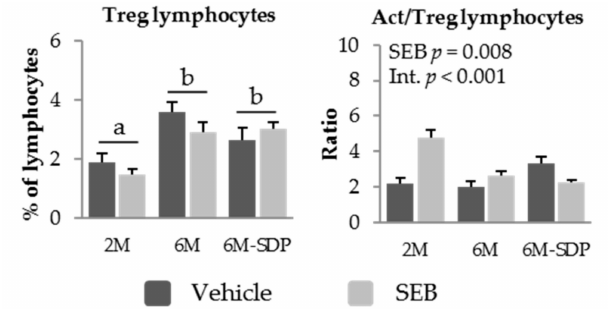
Figure 6. Cell recruitment ( A ); percentage of activated (Act.) Th lymphocytes ( B ); percentage of regulatory (Treg) Th lymphocytes ( C ); and the ratio of activated to regulatory Th lymphocytes ( D ), in Peyer’s patches (PP) of SAMP8 mice of the 2-month-old (2M), 6-month-old (6M), and 6-month-old fed spray-dried plasma (6M-SDP). The dark grey bars represent groups that received the vehicle and the light grey bars represent mice administered with S. aureus enterotoxin B (SEB). Results are expressed as means ± SEM ( n = 6–8 animals). Means without a common letter differ, p < 0.05. Int.,